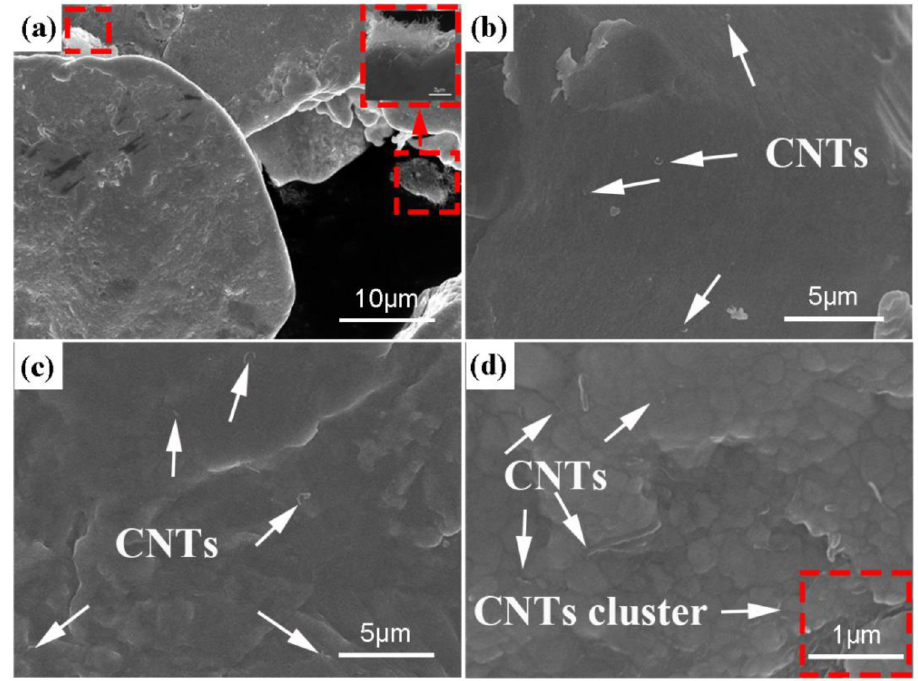
Figure 3. SEM images of ( a ) CNTs / Ag composites powders (2.5 vol.%) and CNTs@Ag / Ag powders mixed by solution ball milling process: ( b ) 1 vol.%, ( c ) 2.5 vol.% and ( d ) 5 vol.%.